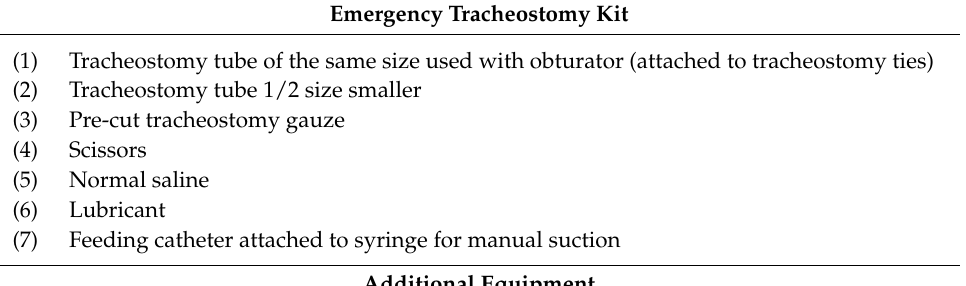
Table 4. Contents of an emergency tracheostomy